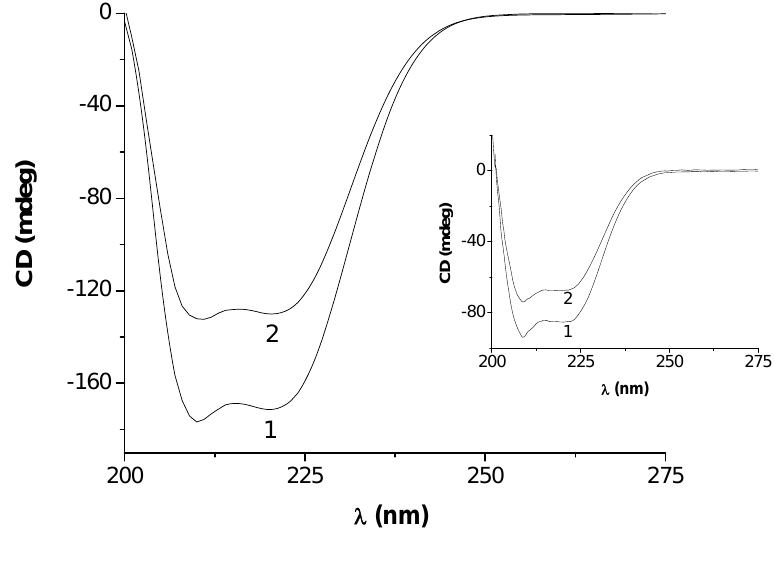
Figure 5 . The CD spectra of HEBID-HSA and HEBID-BSA (inset) systems. [HSA]